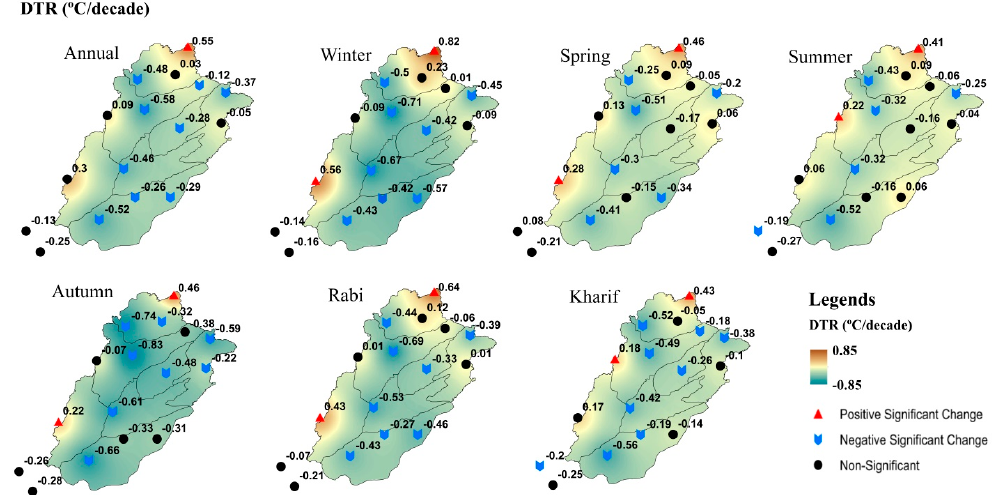
Figure 6. Change per decade and signs of trends at meteorological stations for the DTR of the year, winter, spring, summer, autumn, Rabi, and Kharif in Punjab for the period 1967–2017. The spatial distribution of the annual and seasonal trends of the DTR is presented in Figure 6.